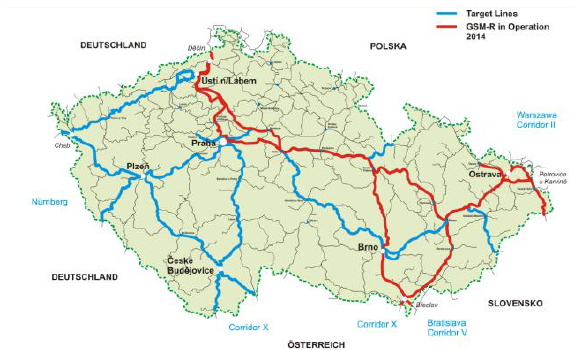
Figure 4. Map of GSM-R implementation [2]